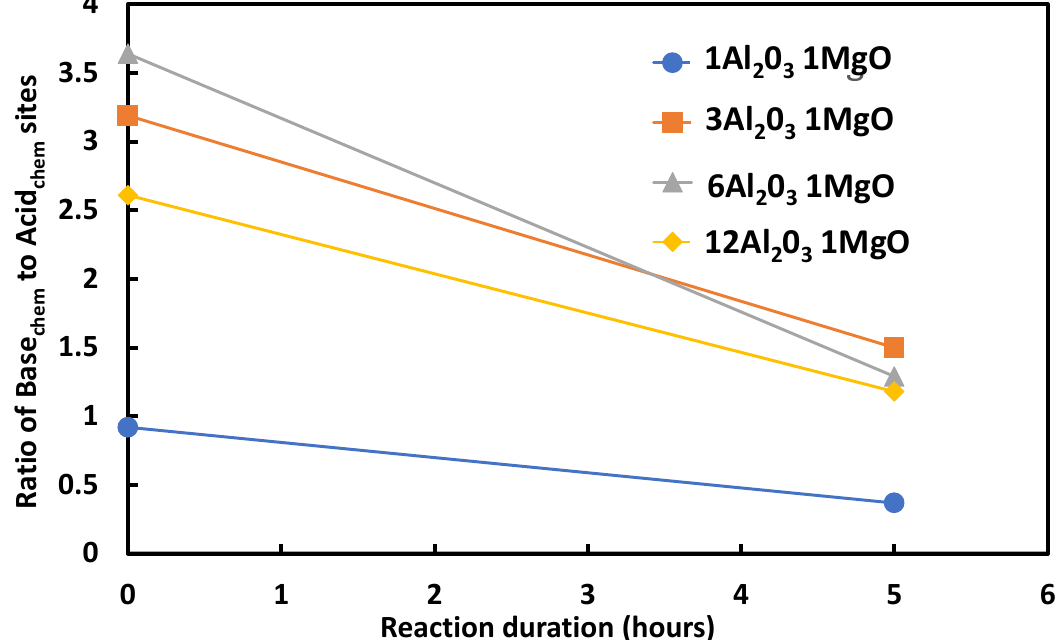
Figure 3. Evolution of ratio of strong basic to strong acidic sites after 0 and 5 h of reaction for spinel catalysts with varying alumina to magnesia ratios.